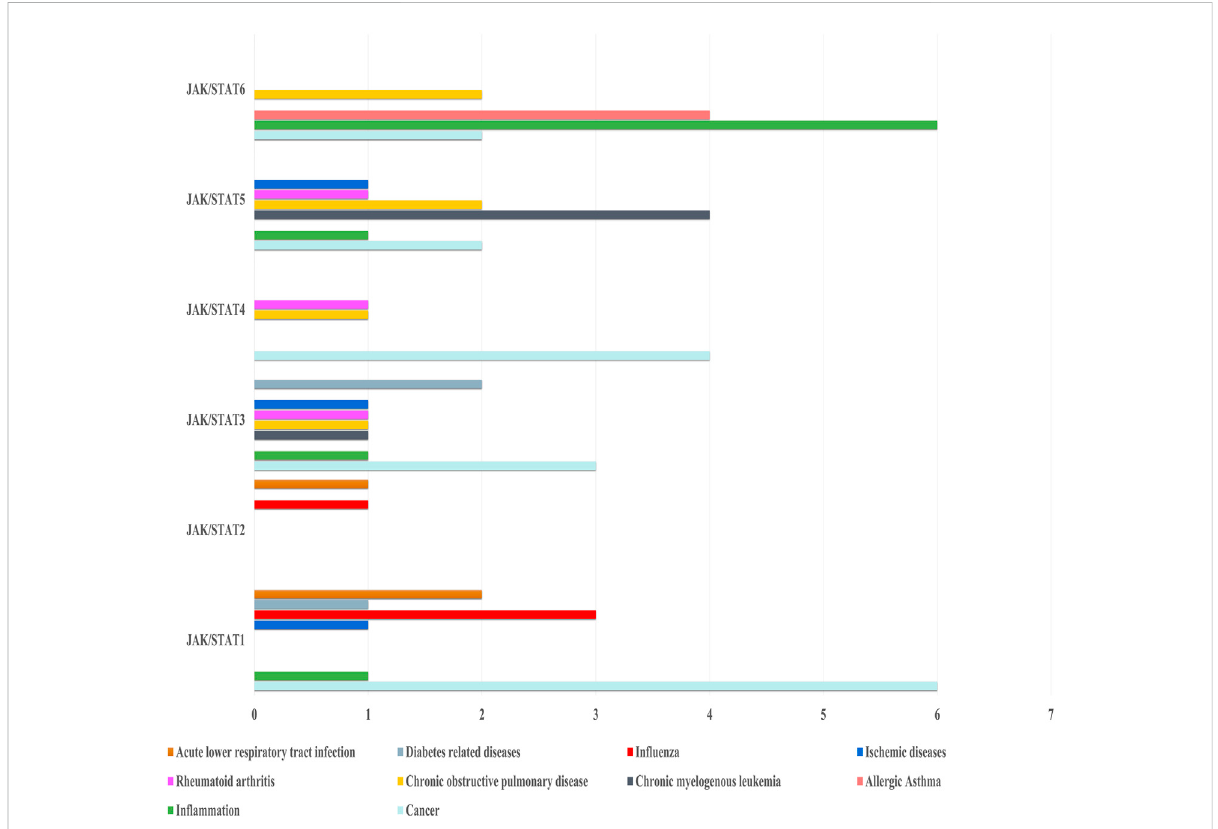
FIGURE 2 TCM formulas and their corresponding extracts or active compounds in the treatment of diseases through regulating the JAK/STAT signaling pathway.